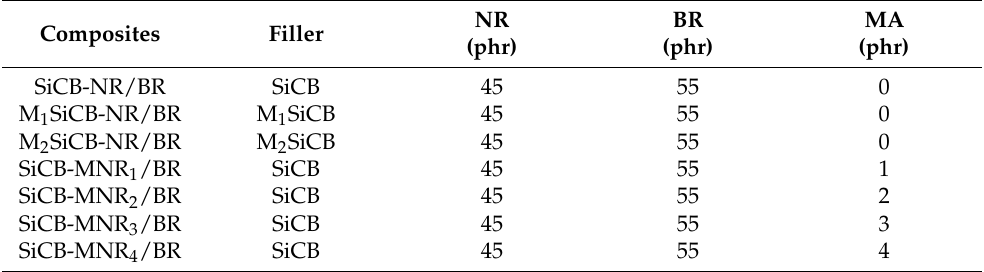
Table 1. Recipes for preparation of